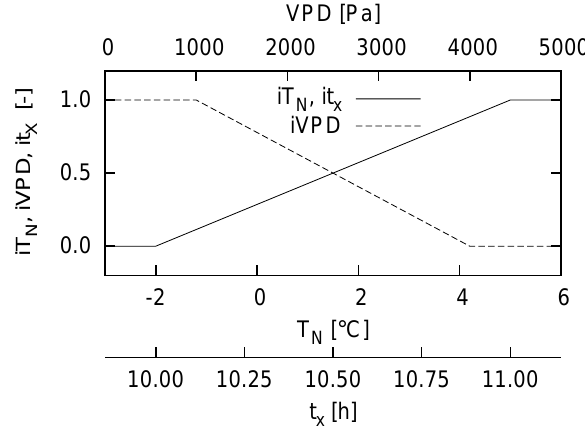
Fig. 1. Index functions for minimum temperature iT N , water vapor deficit i VPD and maximum day length it X (Jolly et al., 2005). With these values the GSI can be calculated with Eq. 1.